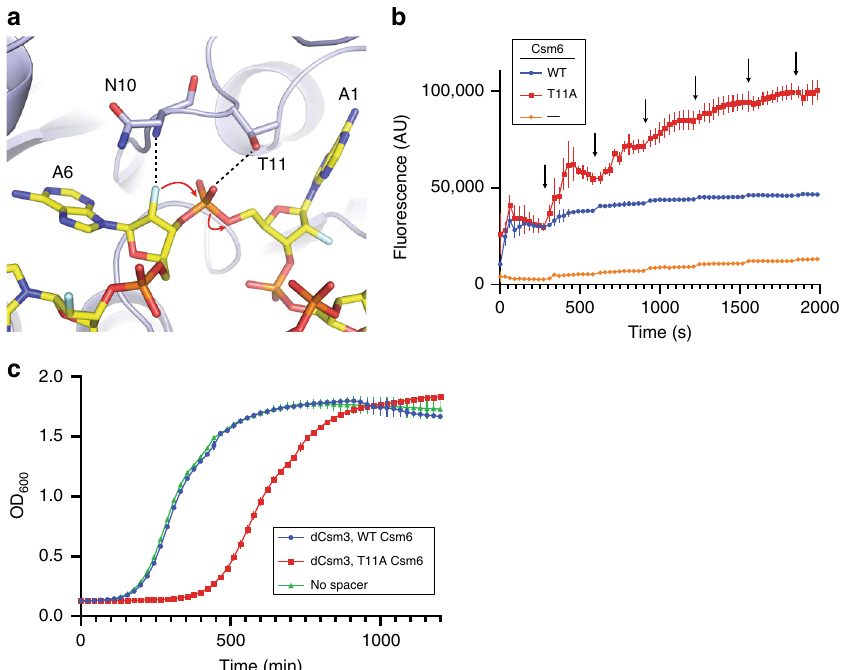
Fig. 3 The CARF domain of EiCsm6 catalyzes cA6 hydrolysis. a Zoom-in view of nucleotides A1 and A6 of cFA6 bound to the EiCsm6 CARF domain. Residues implicated in the cleavage are represented as sticks; hydrogen-bonding interactions are depicted as black dotted lines. The red arrows represent the proposed reaction mechanism of cA6 cleavage involving nucleophilic attack of the 2 ’ -hydroxyl group of A6 onto the phosphodiester group connecting A6 and A1. b RNase activity assay comparing the activity of WT and T11A EiCsm6 proteins in the presence of 500 nM cA6. The black arrows represent spike-ins of 0.8 pmol of RNaseAlert substrate at 5 min intervals. AU, arbitrary units. c Growth curves (optical density at a wavelength of 600 nm) of Staphylococcus aureus strains harboring pTarget and pCRISPR plasmids. The pCRISPR plasmid expresses wild-type or CARF domain mutants of EiCsm6 and the Staphylococcus epidermidis Cas10 – Csm effector complex containing an inactivating point mutation in the Csm3 subunit (D32A; dCsm3). Data points in b , c represent the mean of three replicates; error bars represent the standard error of the mean (s.e.m.). Source data are provided as a Source Data fi